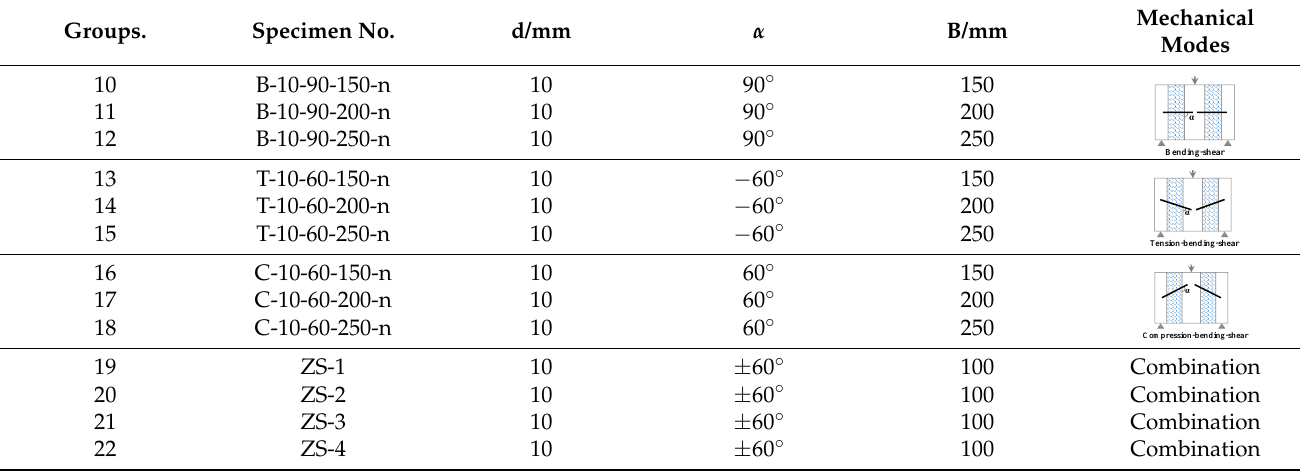
(Figure 2) with thermal conductivity of 0.6 W/(m·K) were introduced as a connector in this study. The BFRP connectors were produced by Jiangsu GMV New Material T&D Co. Ltd. Nanjing , China , and their mechanical properties were shown in Table 2.